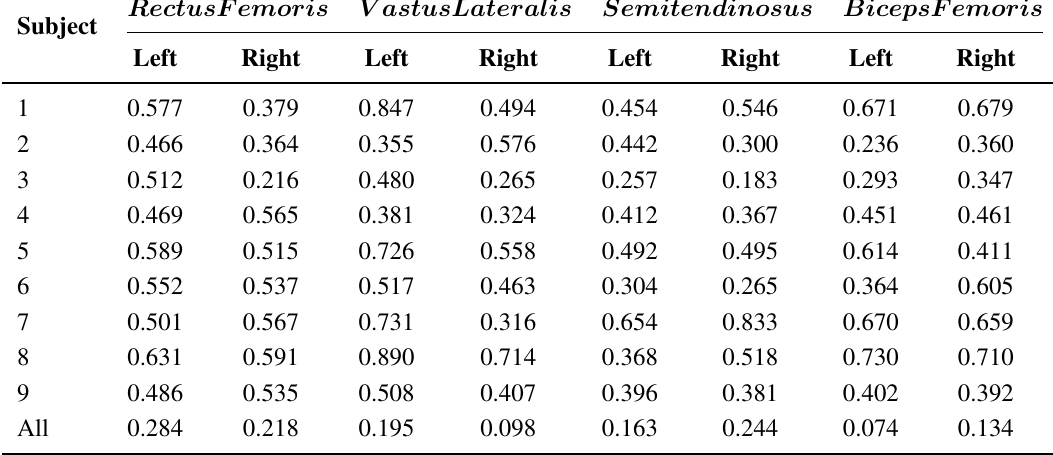
Table 1. The coefficient of determination R 2 for subject-specific, as well as general linear regression models for predicting blood lactate